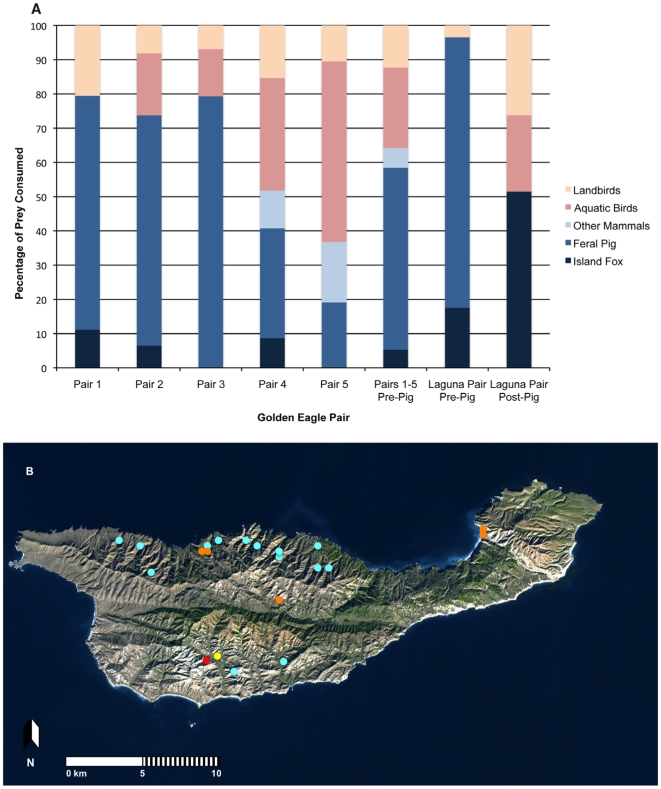
Prey remains and the distribution of golden eagle nests on Santa Cruz Island, California.(A) The percentage of prey biomass collected at five golden eagle nests excavated on Santa Cruz Island, California prior to eradication of the feral pig population and from the Laguna Pair pre- and post-pig removal. (B) The approximate locations of golden eagle nests on Santa Cruz Island. Shown are 14 suspected golden eagle nests (blue circles), the five different nests that were excavated (orange circles) and the two nests of the Laguna Pair, one prior to pig removal (yellow circle) and one after pig removal (red circle).